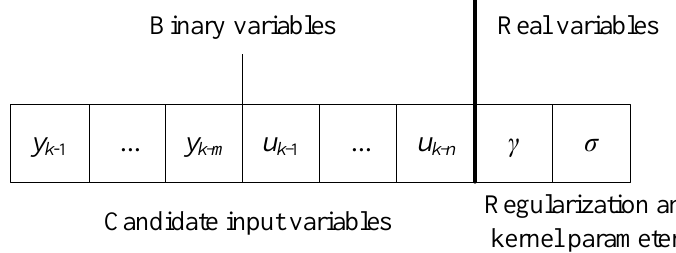
Figure 1. An individual of the binary and real-coded hybrid population.